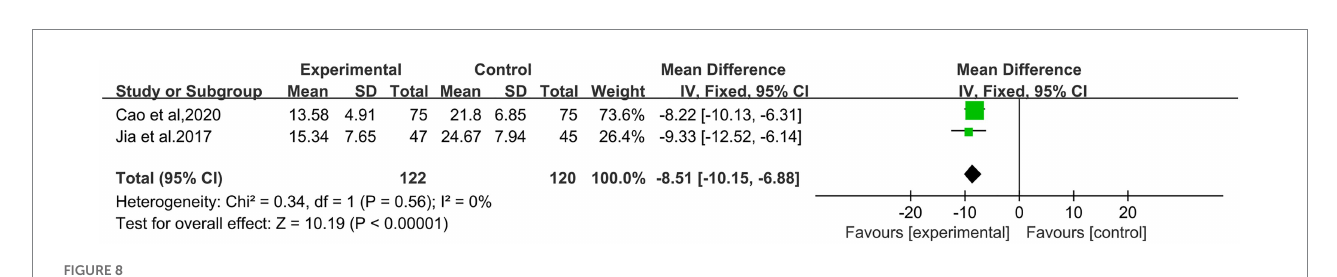
FIGURE 8 Meta-analysis for comparison of HAMD-24 between the experimental and control group.